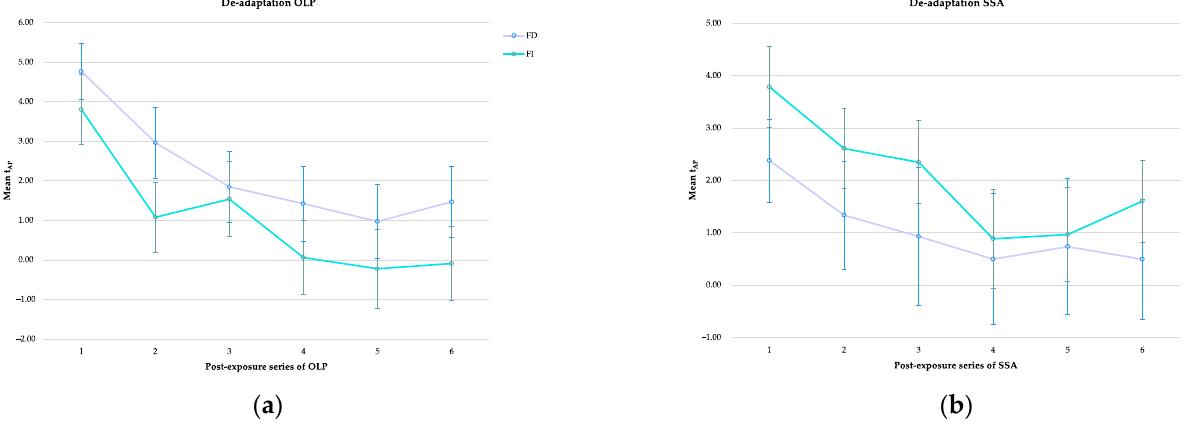
Figure 7. The graphic shows the time gradient of prismatic adaptation (t PA) means ( ± SE) during the de-adaptation phase in each set of open-loop pointing ( a ) and subjective straight ahead ( b ) for field dependent (FD) and field independent